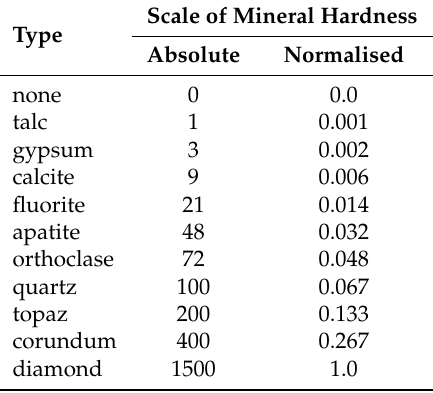
Exemplary comparison of materials’ hardness according to the geological scale of mineral